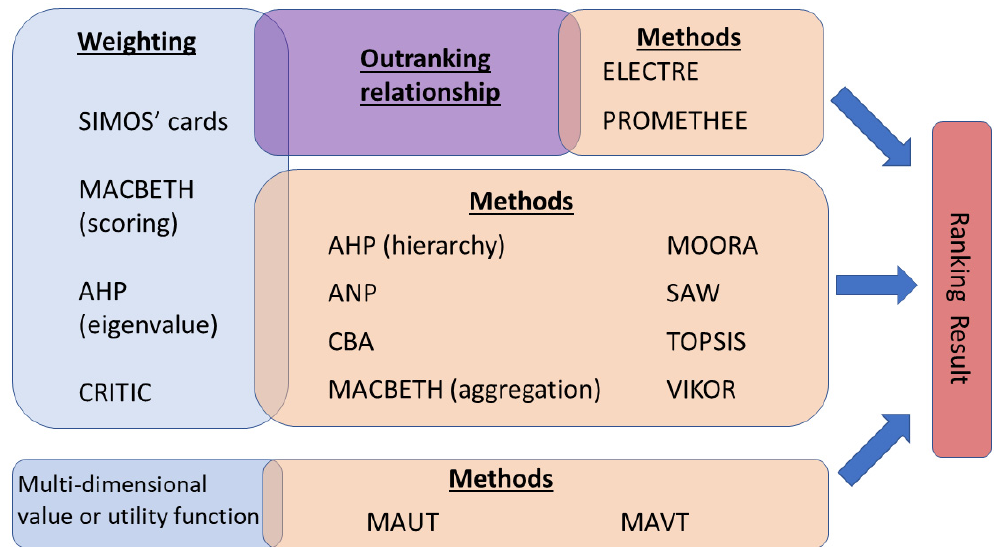
Figure 1. Grouping of multi-criteria decision analysis (MCDA) techniques and components. (Note: citations for all terms in the figure are listed in Table 1. Fuzzy number versions of some of these methods have been developed).